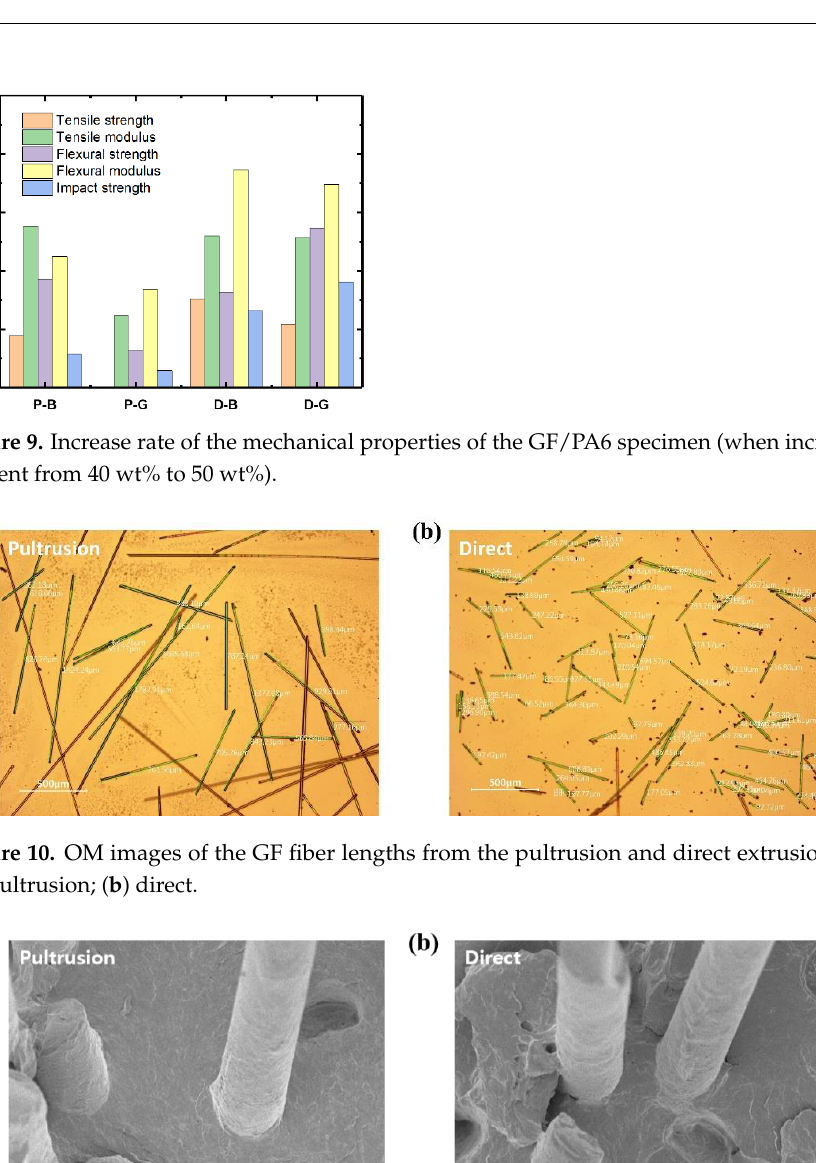
Figure 8. Scatter diagram of the impact strength of the GF/PA6 specimens by fiber volume fraction.